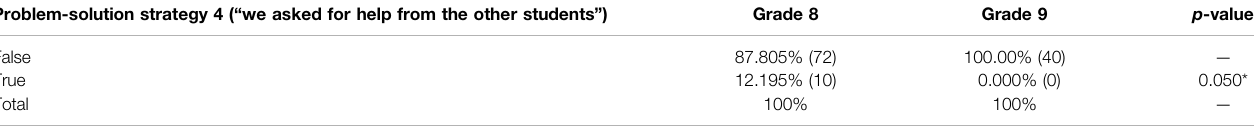
TABLE 3 | Problem-solution “ we asked for help from the other students ” by grades. Problem-solution strategy 4 ( “ we asked for help from the other students ” )